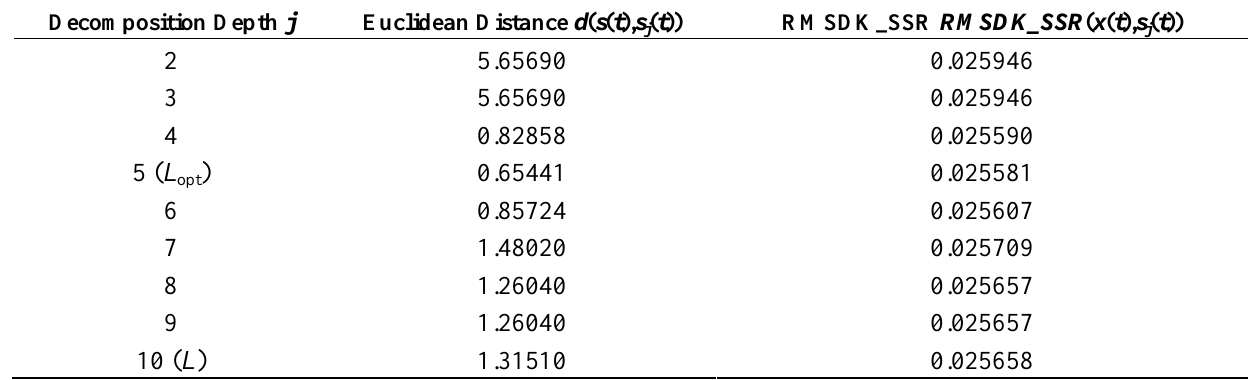
Table 1. Comparison between the Euclidean distance and the